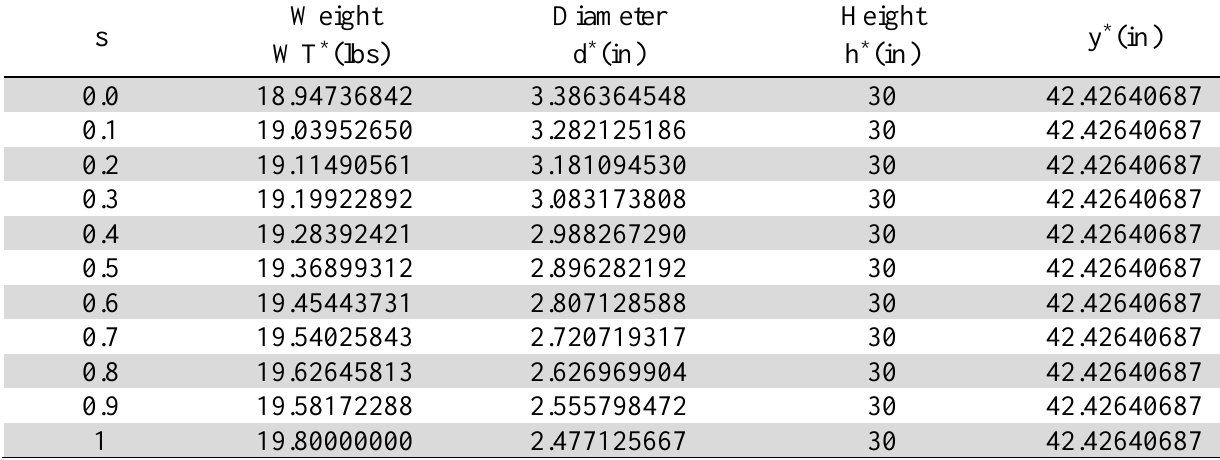
Optimal solution of Two Bar Truss Structural